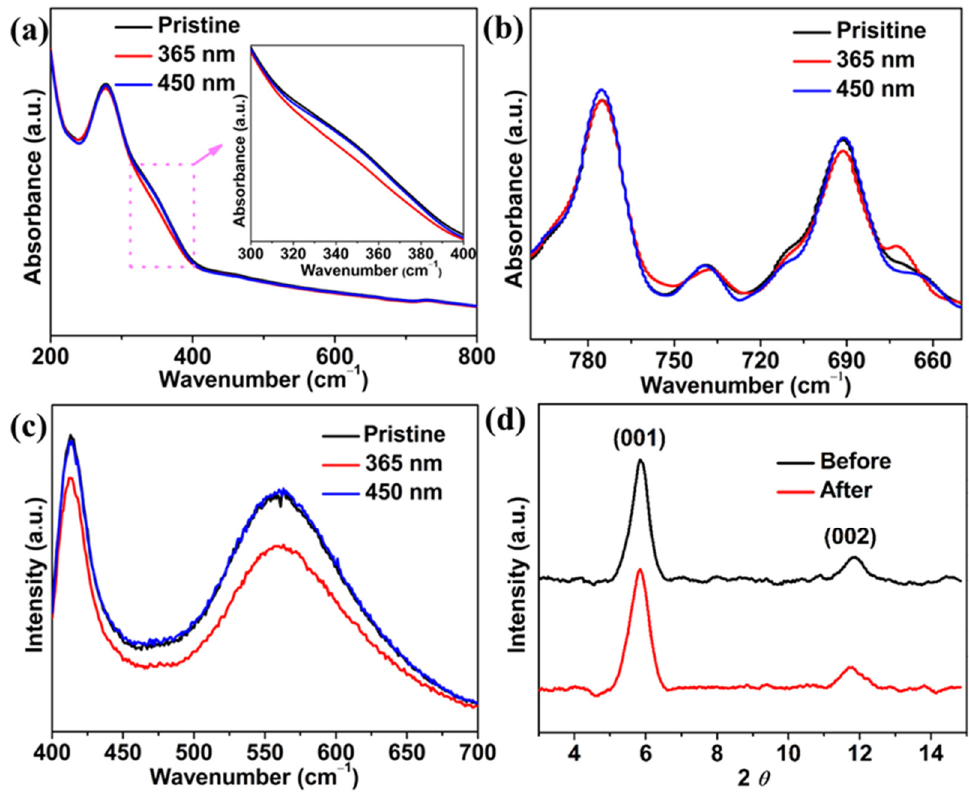
Figure 2. ( a ) UV–Vis ( b ) IRRAS, and ( c ) PL emission spectra of Cu 2 (AzoBPDC) 2 film (pristine (black); after UV irradiation (red,); after visible light irradiation (blue)); ( d ) XRD patterns of Cu 2 (AzoBPDC) 2 film before and after UV–Vis irradiation performed once.